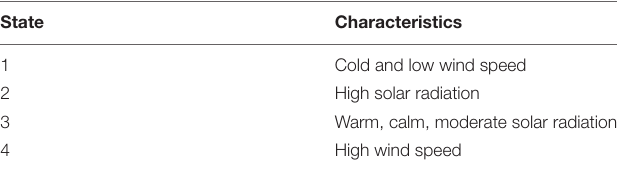
TABLE 4 | Characteristics of the derived state in the example at Blelham